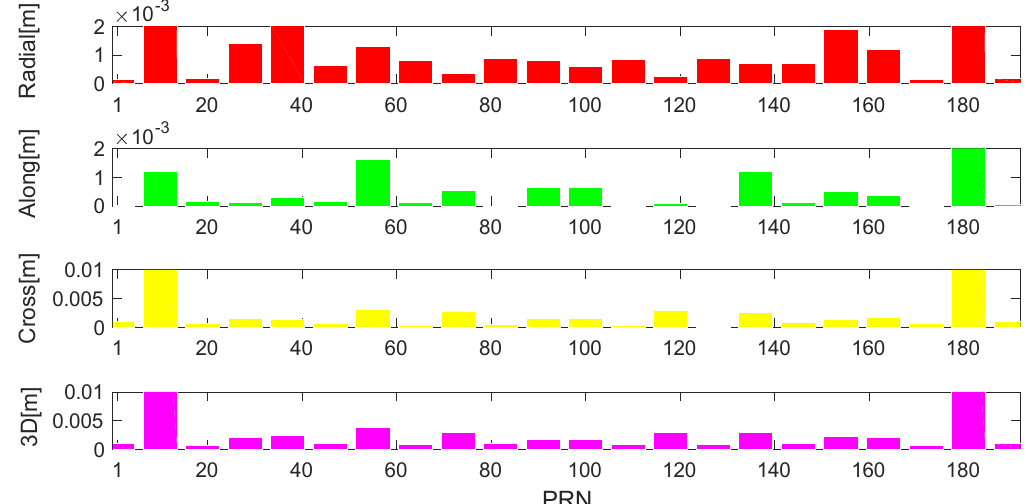
Figure 11. 120-LEO constellation orbital errors in radial, along-track, cross-track, and 3D under 20 cm ranging accuracy, in which satellite of PRN 1,7,13…115 (divided at interval 6 of PRN number) are displayed.